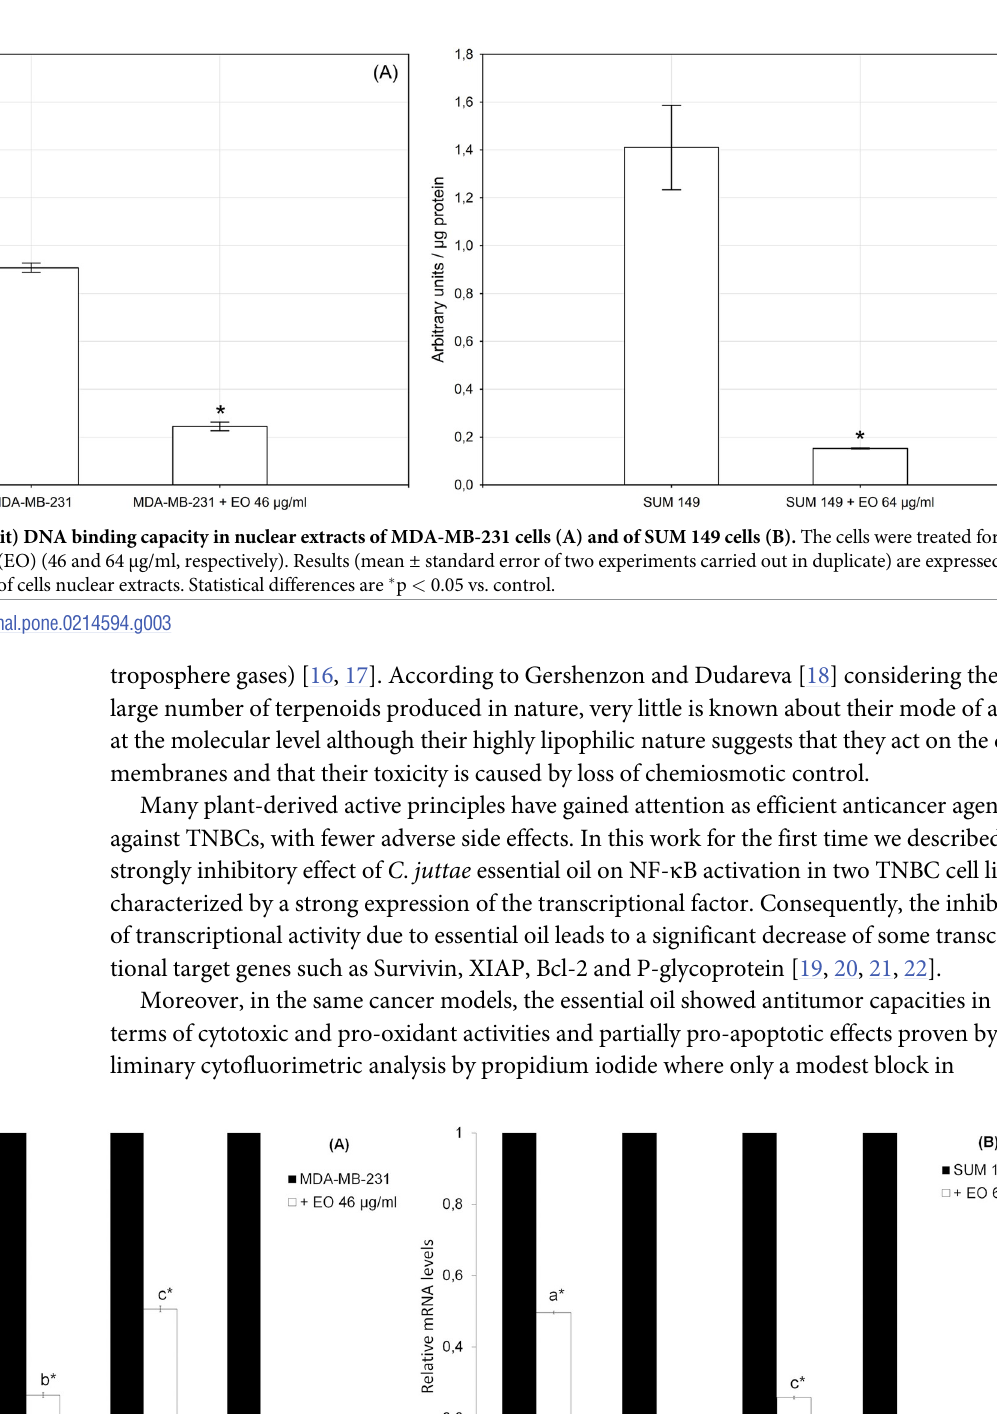
PLOS ONE | https://doi.org/10.1371/journal.pone.0214594 March 28,